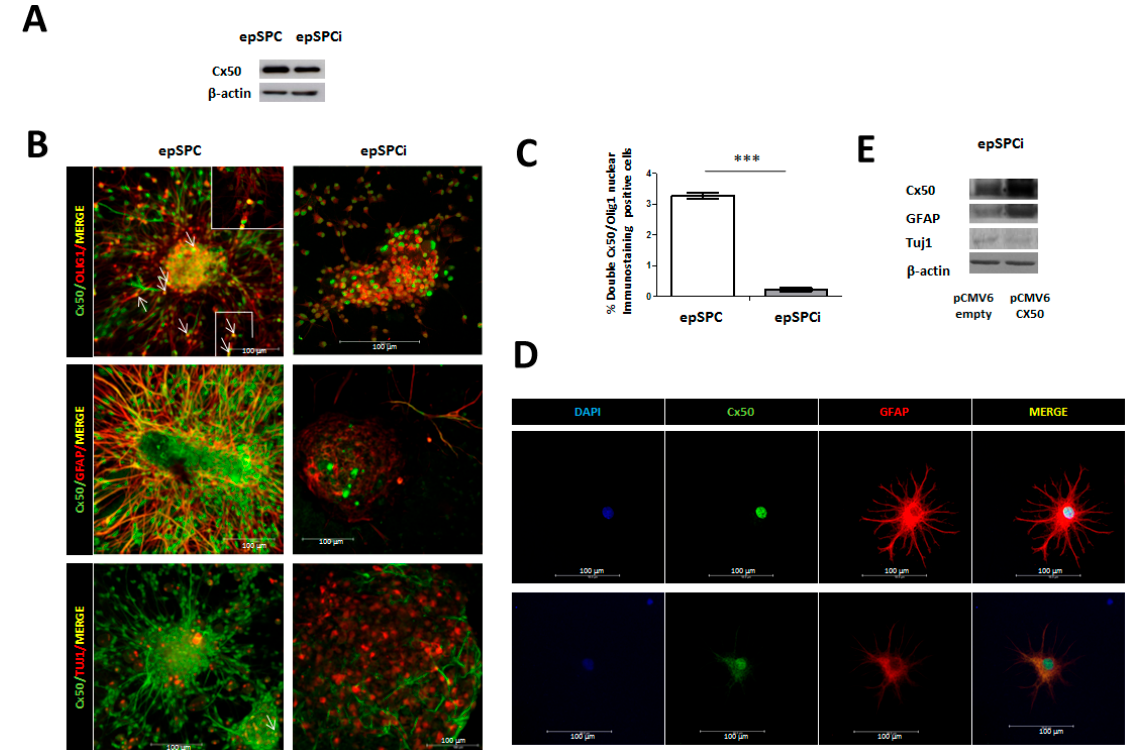
Figure 1. Cx50 expression in epSPC compared to epSPCi and their derived differentiated cells. ( A ) Cx50 exhibited higher protein expression in epSPC compared to activated epSPCi; ( B ) Immunocytochemical analysis of Cx50 simultaneously with the markers for the neuronal lineage (GFAP for astrocytes, Olig1 for oligodendrocytes and Tuj1 for neurons) in epSPC and epSPCi under spontaneous differentiation conditions for 24 h. The inset shows a zoom in area for easier visualization of Olig1 and Cx50 co-localization. Arrows point double-stainings. Scale bar = 100 µm; ( C ) Quantification of co-localization for Cx50 and Olig1; *** p < 0.001 vs. epSPC; ( D ) Immunocytochemistry of Cx50 and GFAP antibodies in primary culture of mature astrocytes isolated from non-injured spinal cord rats. Scale bar = 100 µm; ( E ) Modulation of GFAP and Tuj1 in epSPCi after over-expression of Cx50 by using pCMV6-Cx50 expression vector in comparison to pCMV6-empty (control).